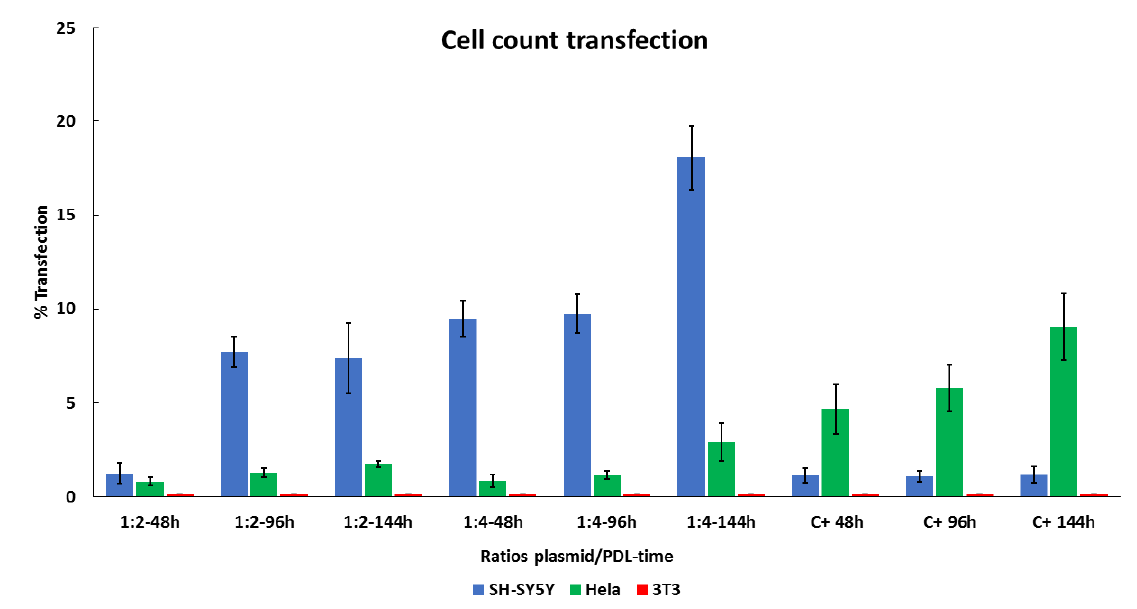
Figure 5. Percentage of transfection in each cell line by cell count. Results are be expressed as EGFP positive cells/total counted cells number counting at least 500 nuclei of each sample. Data are represented by mean ± SD of three distinct experiments.